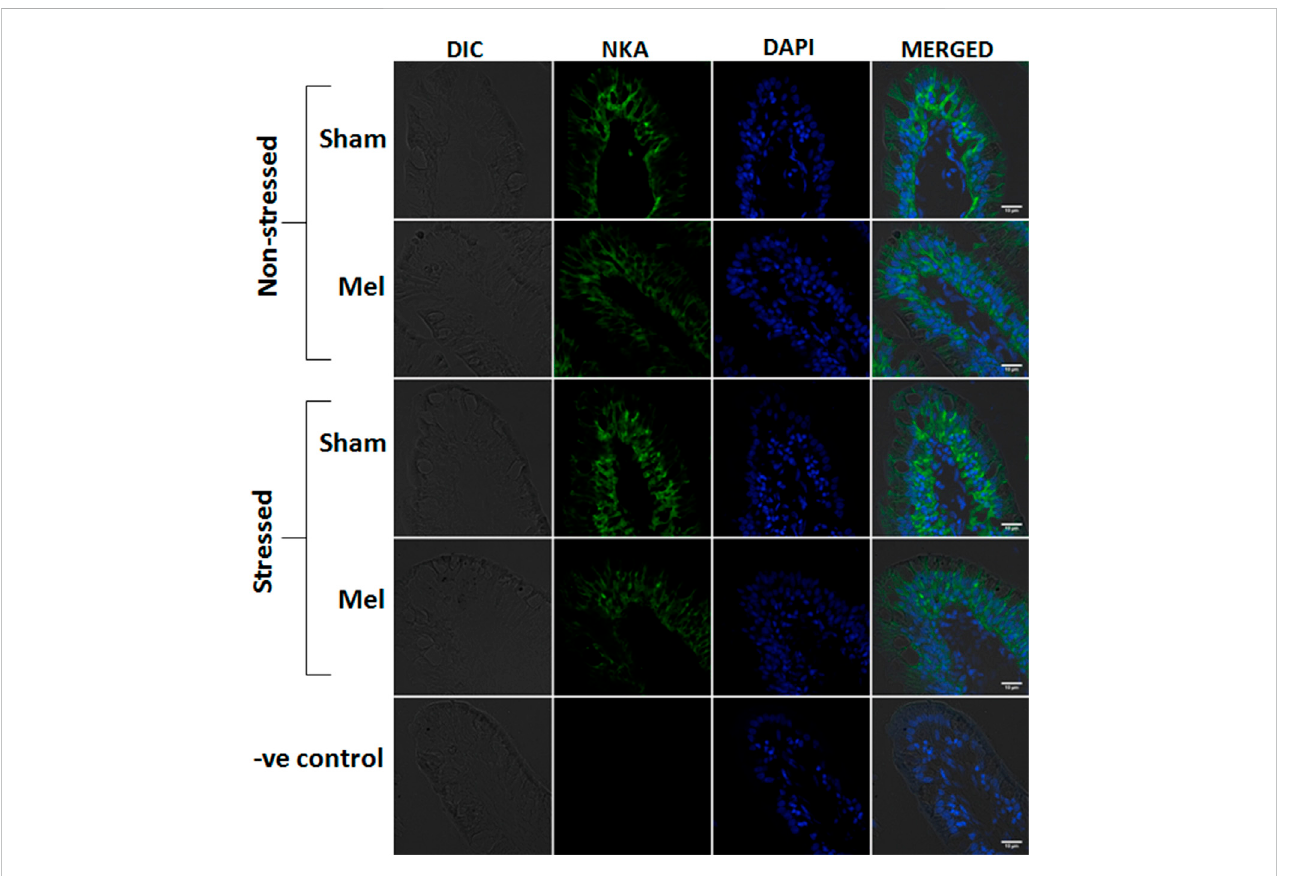
FIGURE 12 Confocal images showing the distribution of NKA α 1-rich immunoreactivity in the intestinal villi of climbing perch after melatonin treatment (Mel) in nonstressed and immersion stressed (IMR) condition. NKA-immunostaining was seen on the basolateral sides of columnar epithelial cells, which act as entric ionocytes, and nuclei are counterstained with DAPI. Each panel consists of representative images of intestinal villi of fi sh from each group and starts with DIC image, fl uorescence images of NKA α 1 (green) and DAPI (blue) and its merged form in DIC. Last panel represents the corresponding images of negative control in which primary antibody incubation was omitted. Scale bar = 10 μ